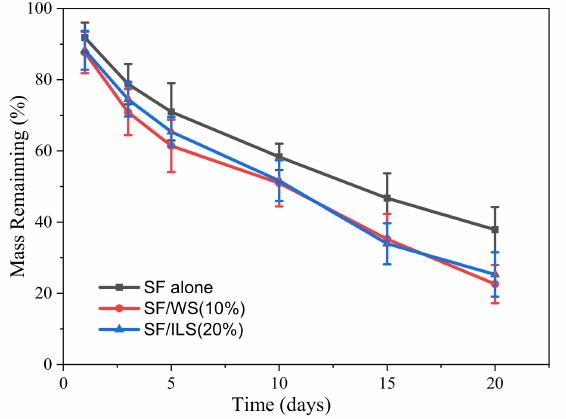
Figure 10. Enzymatic hydrolysis behavior of pure SF scaffold and SP composite scaffolds. The SF alone, SF/WS (10%), and SF/ILS (20%) represent the grafted SF scaffold and the two SP composite scaffolds mixed with 10% G-WS and 20% G-ILS, respectively; n =